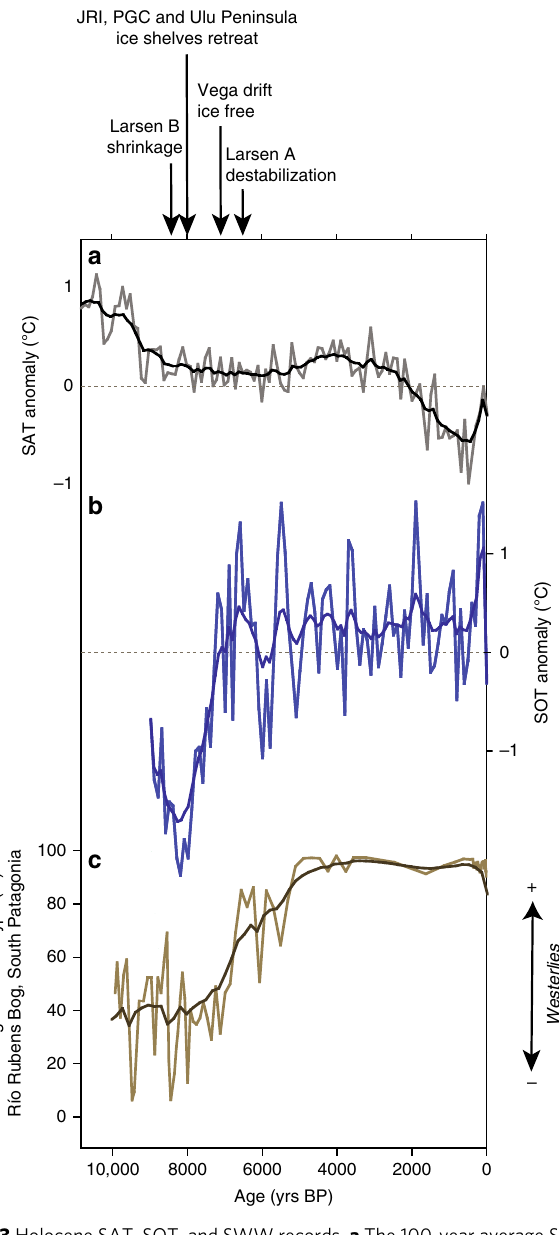
Fig. 3 Holocene SAT, SOT, and SWW records. a The 100-year average SAT anomaly at the JRI core site (gray) 27 , b the 100-year average TEX L 86 -derived SOT anomalies reconstructed at the JPC-38 (blue) and their respective smoothed records spanning the last 9000 years. c Nothofagus pollen record (%) at the Río Rubens Bog site, Patagonia, east of the Andes, Argentina, re fl ecting intensity and southward migration of the Westerlies 41 – 43 . The black arrows represent the major steps of the EAP